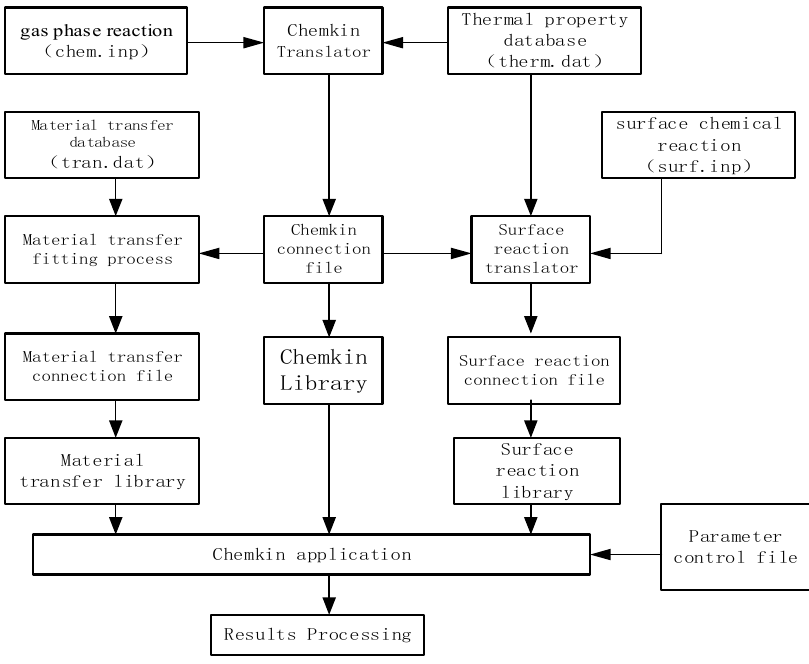
Figure 4. CHEMKIN-PRO structure diagram.